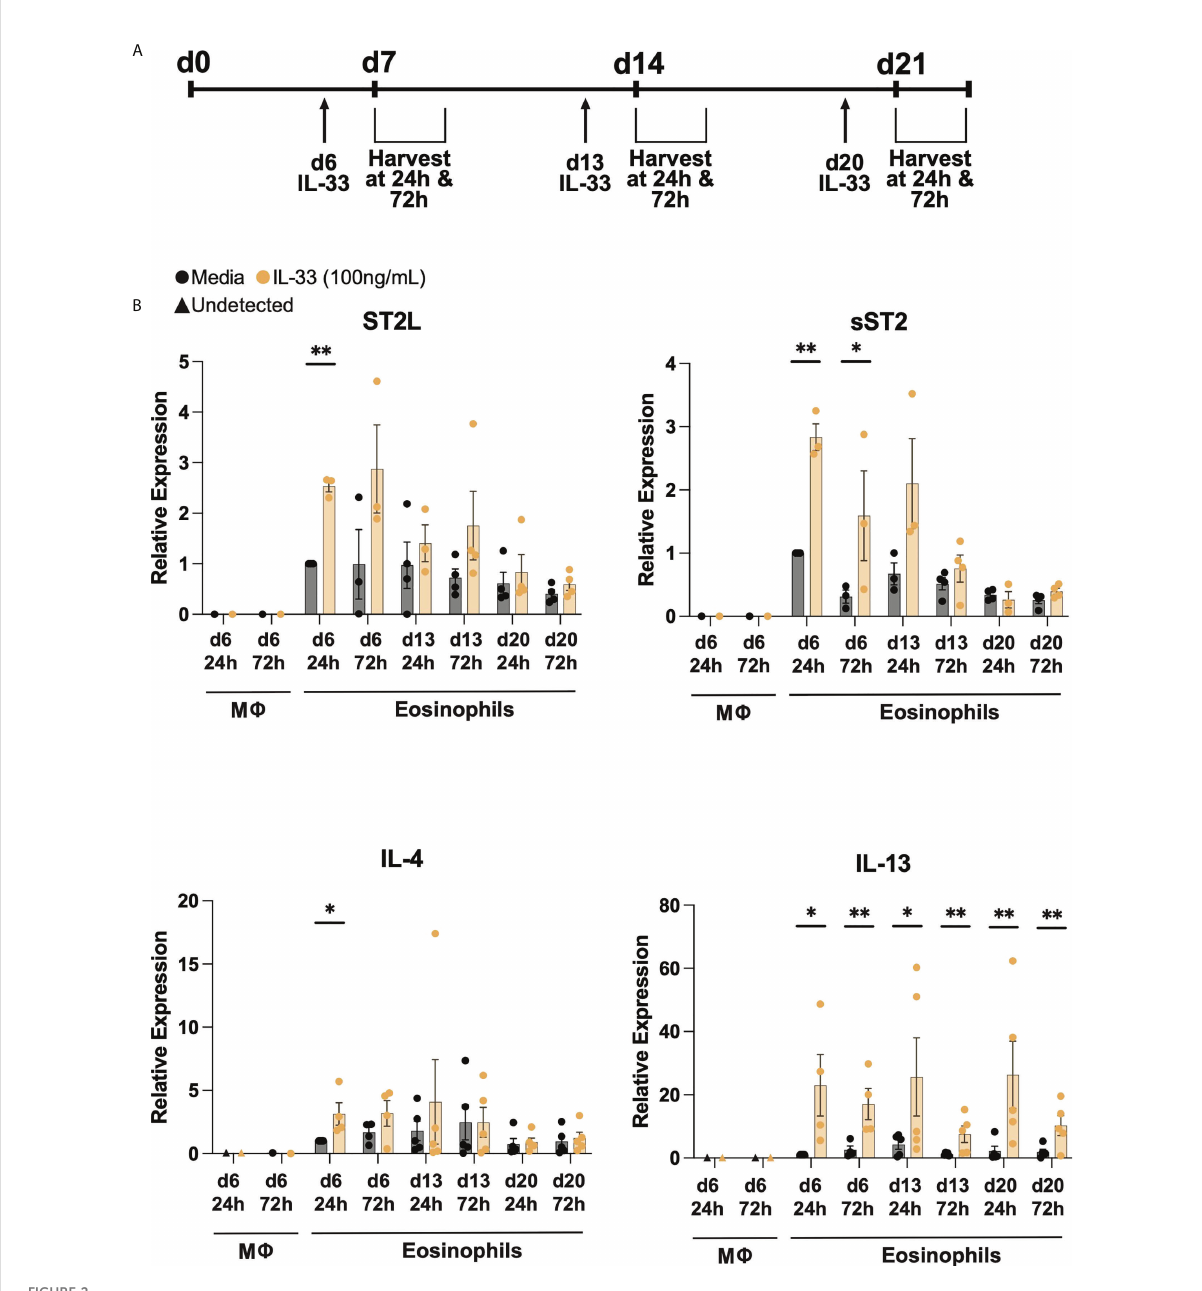
FIGURE 2 Differentiated eosinophils express IL33 receptor and type 2 cytokine transcripts. (A) IL-33 stimulation schema during differentiation. Cells were treated with IL-33 or media control on days 6, 13, and 20 (d6, d13, d20) and subsequently harvested 24h and 72h after each stimulation. (B) Relative expression levels of ST2L, sST2, IL-4 , and IL-13 using d6 24h media eosinophils as the control for each qRT-PCR. P < 0.05 (*), <0.0021